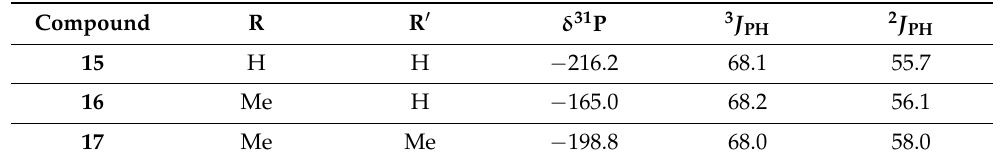
Table 3. The 31 P NMR chemical shifts ( δ , ppm) and coupling constants ( J , Hz) of hexacoordinated N -vinylpyrazoles ( 15 – 17 ).